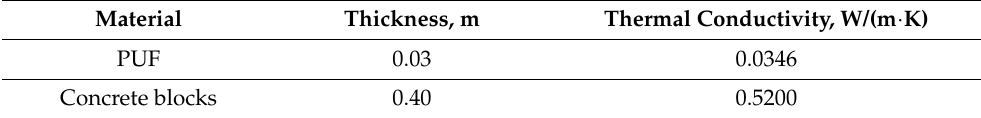
Table 1. Characteristics of the materials of the building’s enclosure construction.